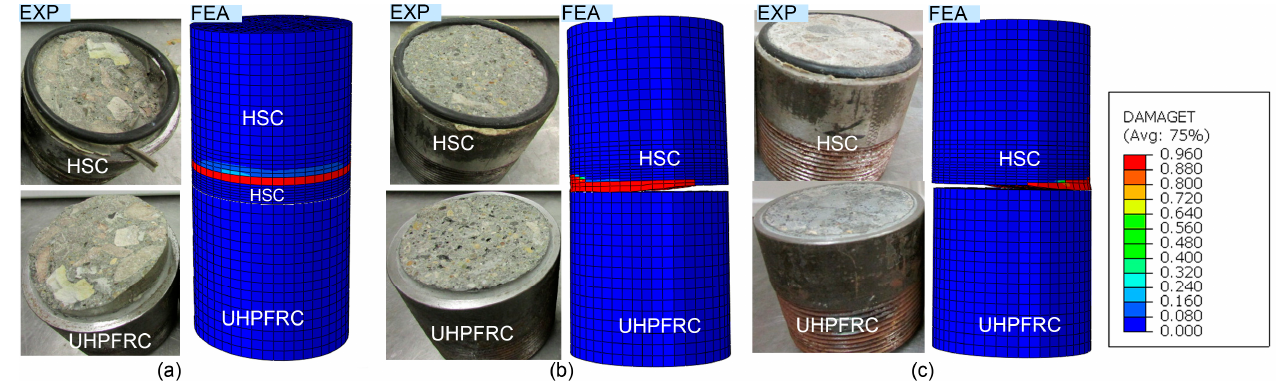
Figure 13. Comparison of the failure of the HSC ‐ UHPFRC specimens between the EXP [21] and FEM simulations in three distinct surface types in the tensile test: ( a ) rough interface; ( b ) mid ‐ rough interface; and ( c ) smooth interface.